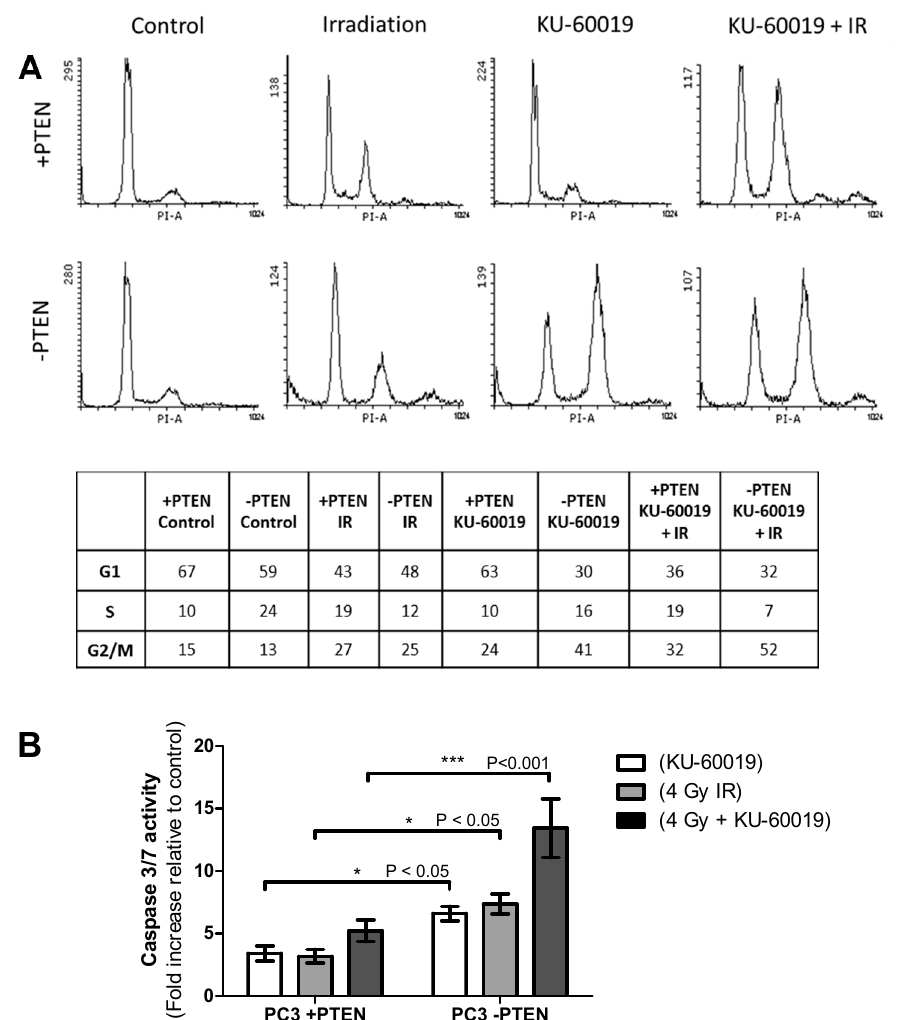
Figure 3. Changes in cell cycle distribution and caspase activity and its dependency on PTEN status and the combination of radiation with KU-60019. ( A ) Cell-cycle analysis using Propidium iodide (PI) staining and detection by flow cytometry of PC-3 +PTEN and − PTEN cell models after treatment with 1 µ M KU-60019 and 2 Gy IR, as single modalities and in combination. Analyses of cell cycle distributions 48 h post-treatment are shown. ( B ) Caspase 3/7 activity in PC-3 PTEN isogenic cell models following treatment with 1 µ M KU-60019 and 4 Gy IR alone or in combination. Activity was measured using a Caspase-Glo 3/7 assay kit 48 h post-treatment. Differences between two groups were compared by using a two-sample student’s t-test (one asterisk (*), p < 0.05; three asterisks (***), p < 0.001).